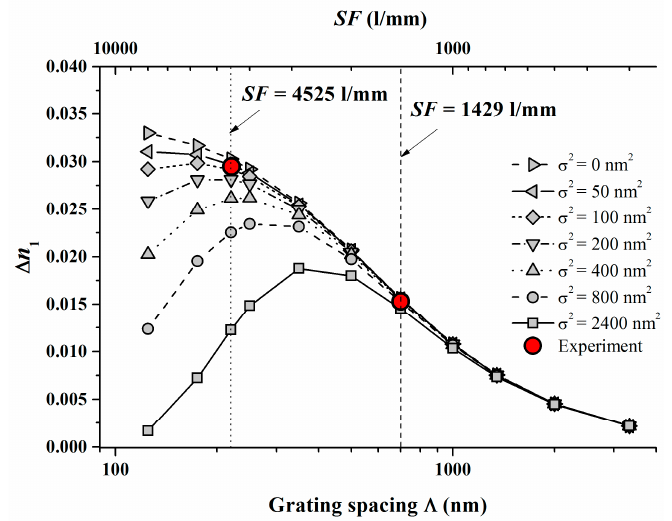
Figure 4. Calculated ∆ n 1 versus Λ = 1/ SF for varying non-local parameters σ 2 and P ave = 8 mW/cm 2 . The filled symbols indicate the respective experimental values measured at SF = 1429 L/mm (dashed line) and SF = 4525 L/mm (dotted line) [17].